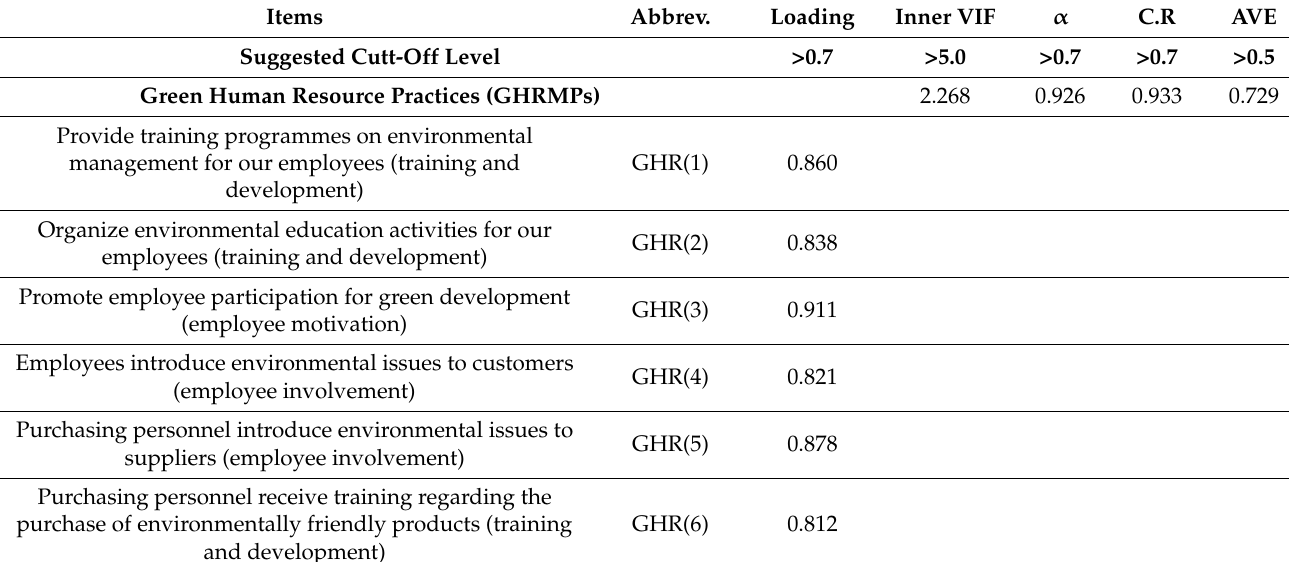
Table 2. Calculations of the Outer